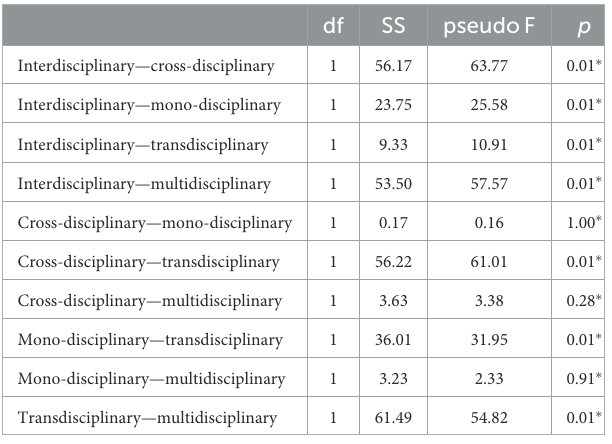
TABLE 4 Pairwise A-posteriori tests between the different collaboration